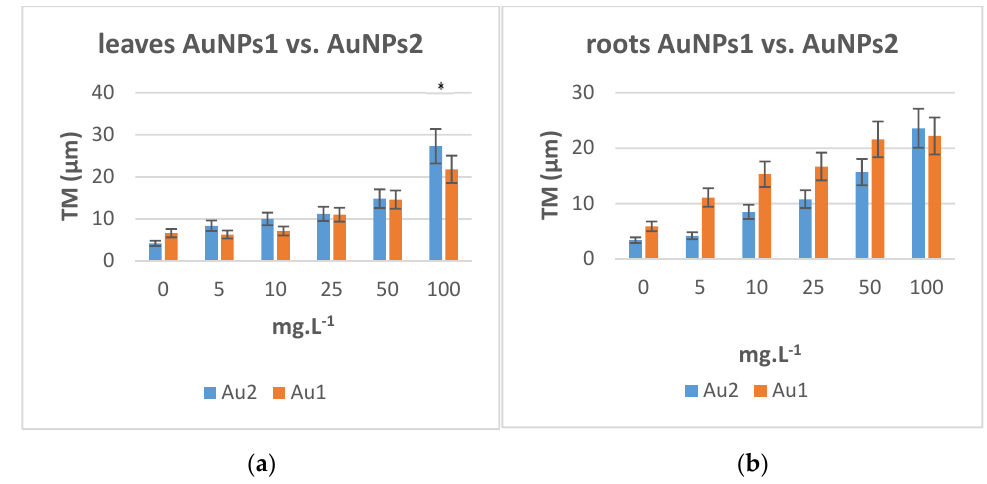
Figure 4. ( a ) The averaged median tail moments (TM) in leaf nuclei after a 24 h treatment at 26 °C of 4–5 weeks old tobacco ( N. tabacum ) plants with aqueous solutions of AuNPs. ( b ) The averaged median tail moments (TM) in root nuclei after a 24 h treatment at 26 °C of 4–5 weeks old tobacco ( N. tabacum ) plants with aqueous solutions of AuNPs (size AuNPs1 12–15 nm and AuNPs2 22–25 nm). The error bars represent the standard error of the mean. (*) Significantly ( p < 0.05) different from the control.